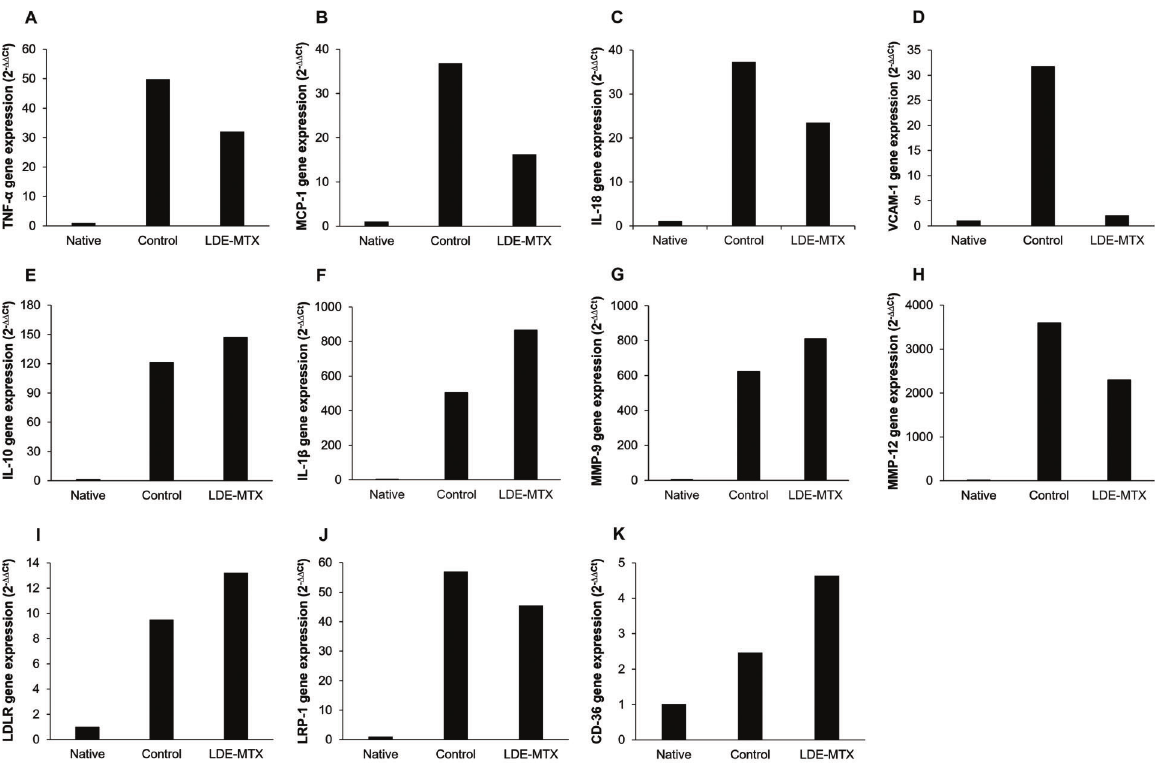
Figure 2. Effects of the treatment with lipid nanoemulsion-methotrexate (LDE-MTX) on gene expression of in fl ammation markers and lipoprotein receptors in grafted hearts. Gene expression of TNF- a (A), MCP-1 (B), IL-18 (C), VCAM-1 (D), IL-10 (E), IL-1 b (F), MMP-9 (G), MMP-12 (H), LDLR (I), LRP-1 (J), CD-36 (K), in control native and grafted hearts, and LDE-MTX grafted hearts of the rabbits. Total RNA was isolated from cardiac tissue and pooled samples of each group were reverse transcribed into cDNA. Quantitative real time PCR was used to calculate relative gene expression of target genes comparing the mean of the pool of grafted hearts of control and LDE-MTX groups versus the mean of the pool of native hearts of control group.